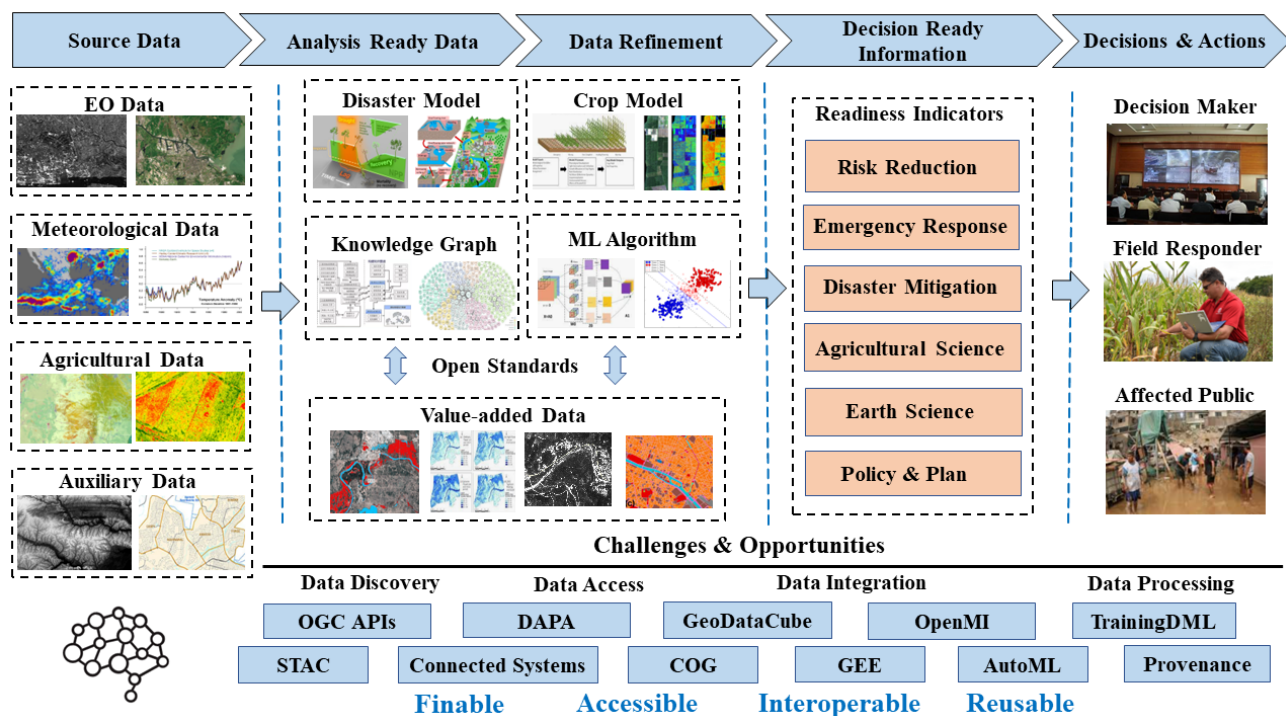
Figure 4. Challenges and